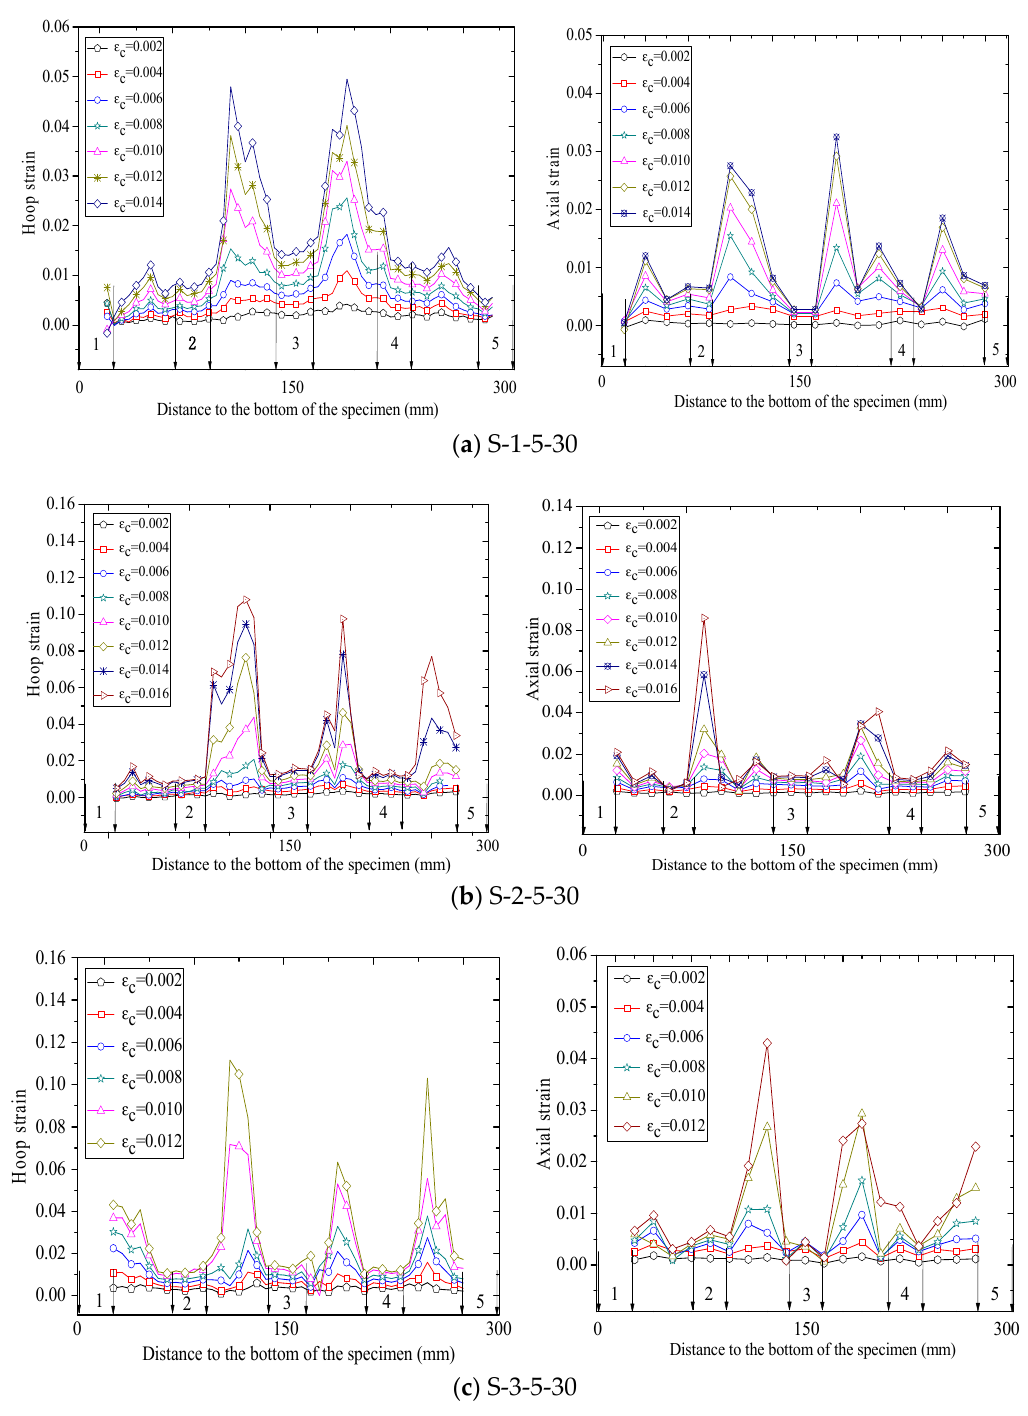
Figure 12. Strain distribution along the column height (specimens wrapped with five strips).